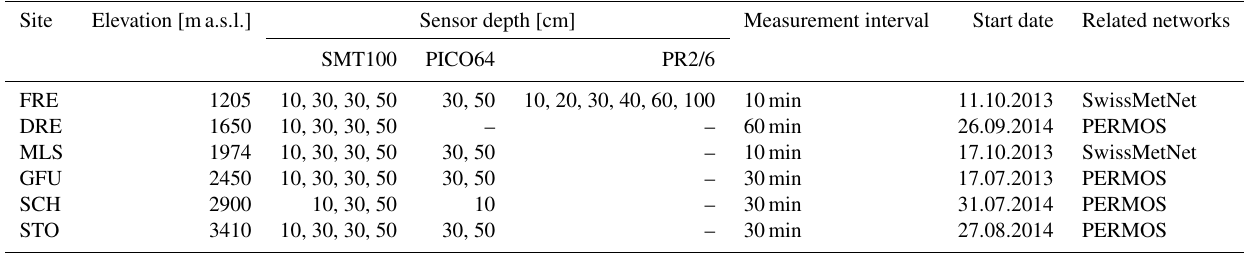
Table 2. Summary of the station instrumentation and characteristics at the field sites Frétaz (FRE), Dreveneuse (DRE), Moléson (MLS), Gemmi (GFU), Schilthorn (SCH) and Stockhorn (STO).